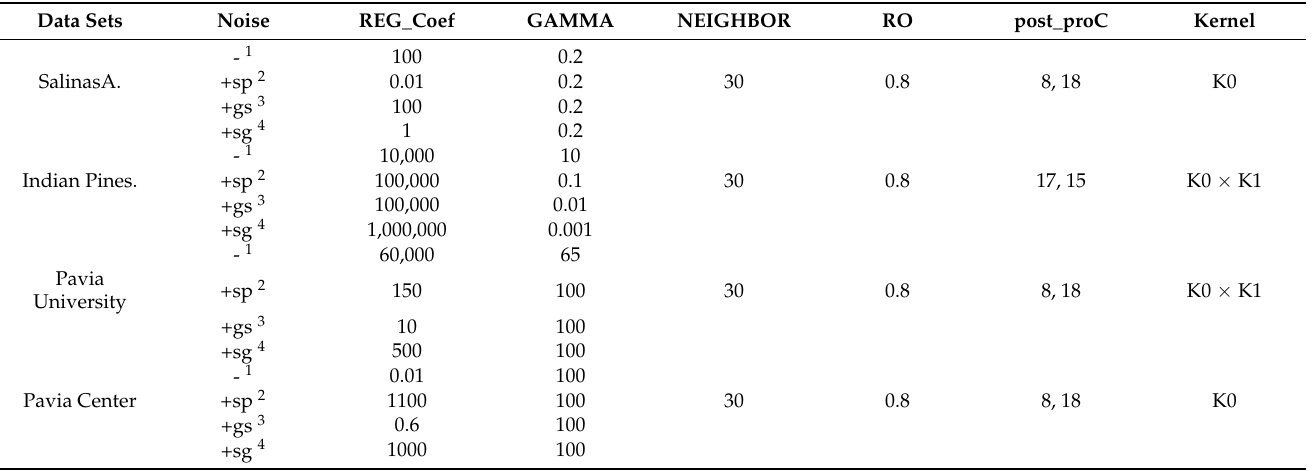
Table 2. Settings of the important hyperparameters in SSAKGCSC. Data